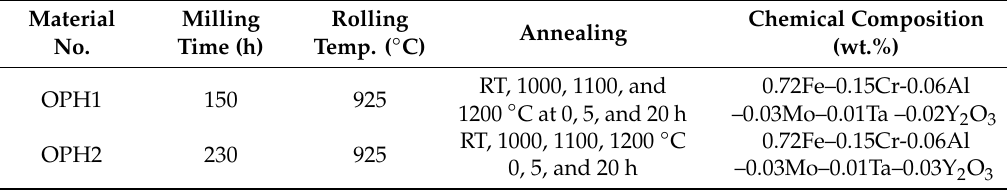
Table 1. Material properties (RT—room